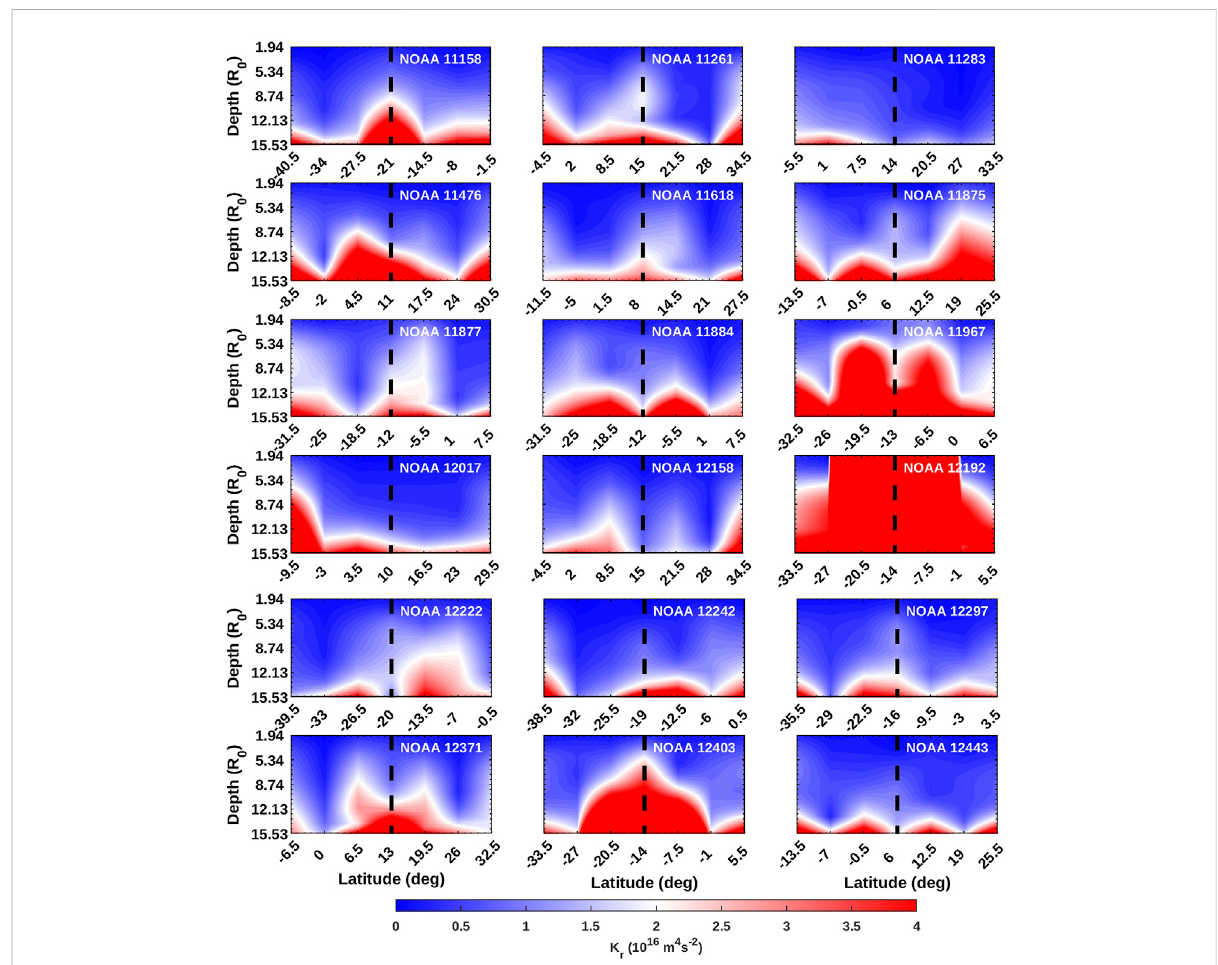
FIGURE 4 Temporalmeanofabsolutekinetichelicity,K r correspondingtothe fl aringactiveregionsandneighboringpatchesat φ ar asafunctionoflatitude and depth. Dashed lines represent the active region